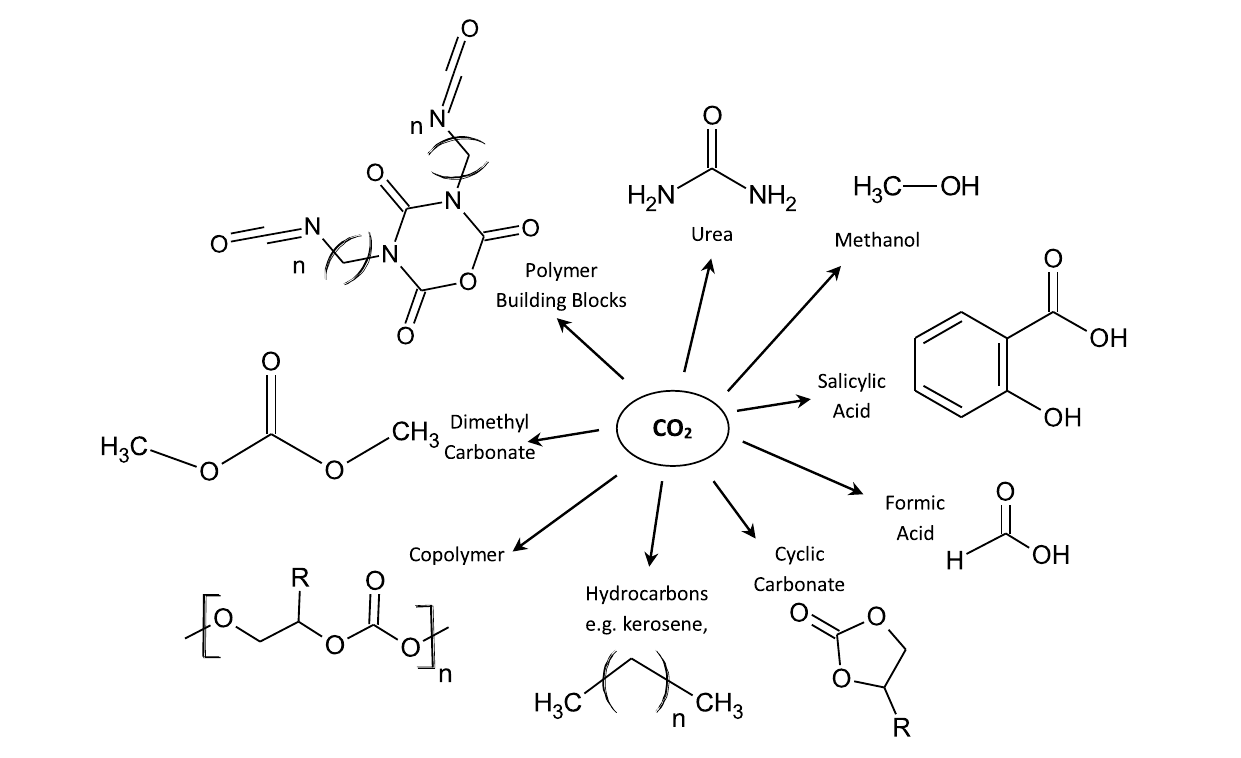
FigUre 1 | An overview of potential pathways for use of CO 2 as a C1 building block [adapted from Styring et al. (2011)] (CO2Chem Media & Publishing have granted permission for the adaptation of this image for use in this study).